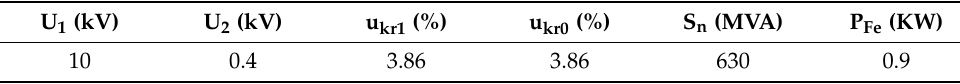
Table 1. Transformer’s parameters in the observed LV